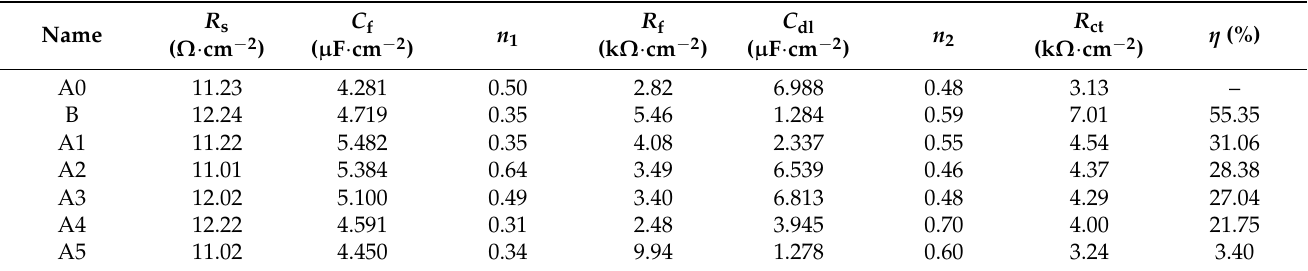
Figure 4. Equivalent circuit model used to fit EIS results. Table 3. Fitting values of the Nyquist plots after 11 drying–wetting cycles.